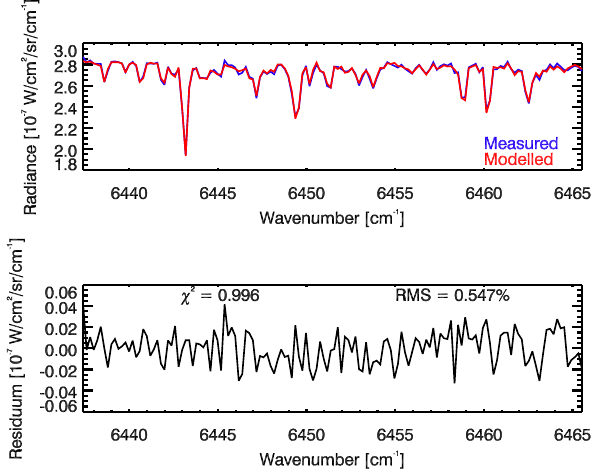
Fig. 7. Column averaging kernel for the TCCON H 2 O and HDO retrtieval over Orleans, France on 31 July 2010. Shown are the kernels for a SZA of 30 (cid:14) (thick lines) and 60 (cid:14) (thin lines). The red lines are for the TCCON fit windows and the black lines for the GOSAT fit window.